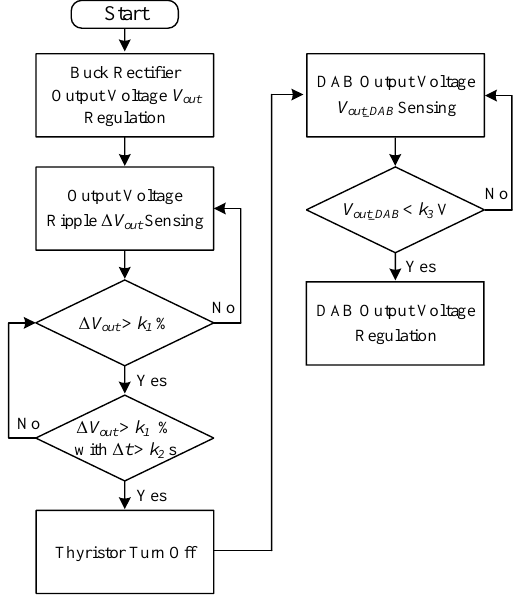
Figure 11. Flowchart of the proposed protection algorithm.